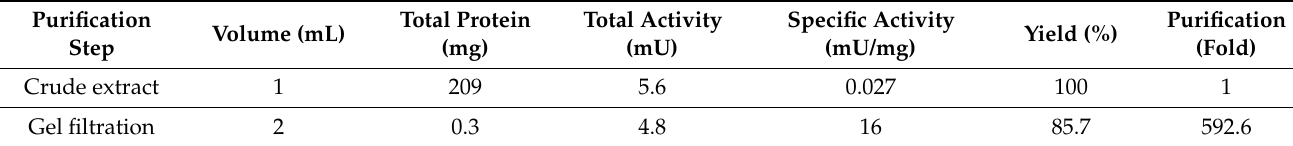
Table 1. Purification of β -xylosidase SRBX1 from S. reilianum .